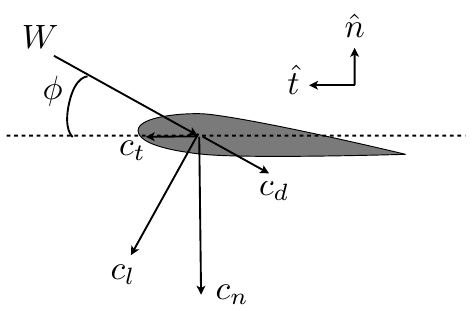
Figure 10. Definition of normal and tangential force